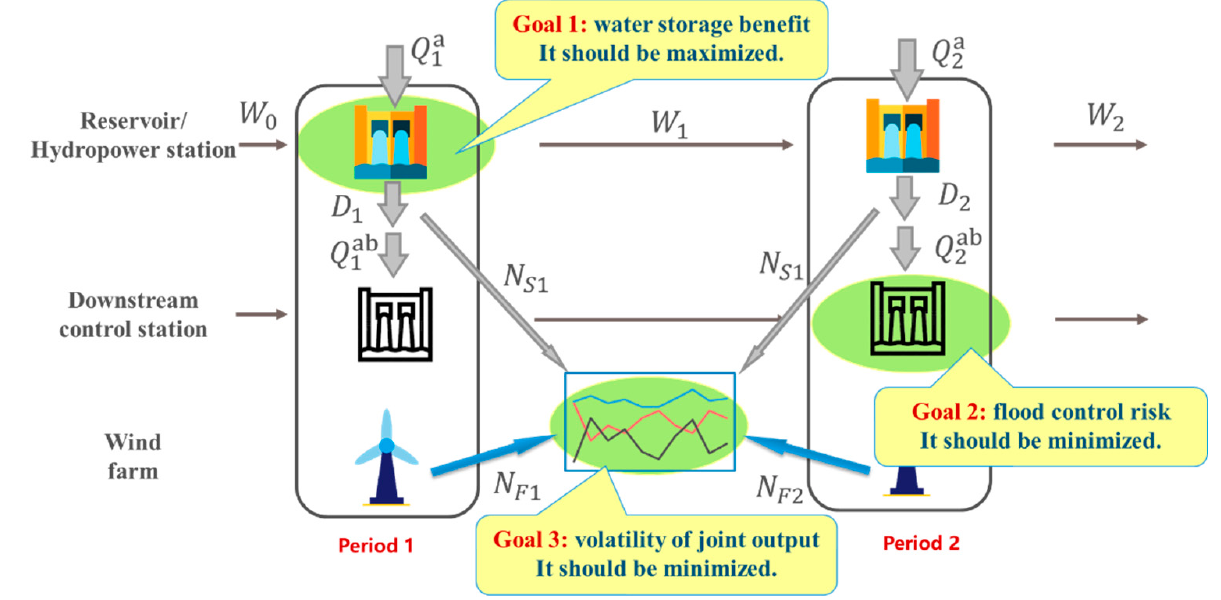
Figure 4. Two-stage decision diagram for joint dispatch of hydropower and wind power.